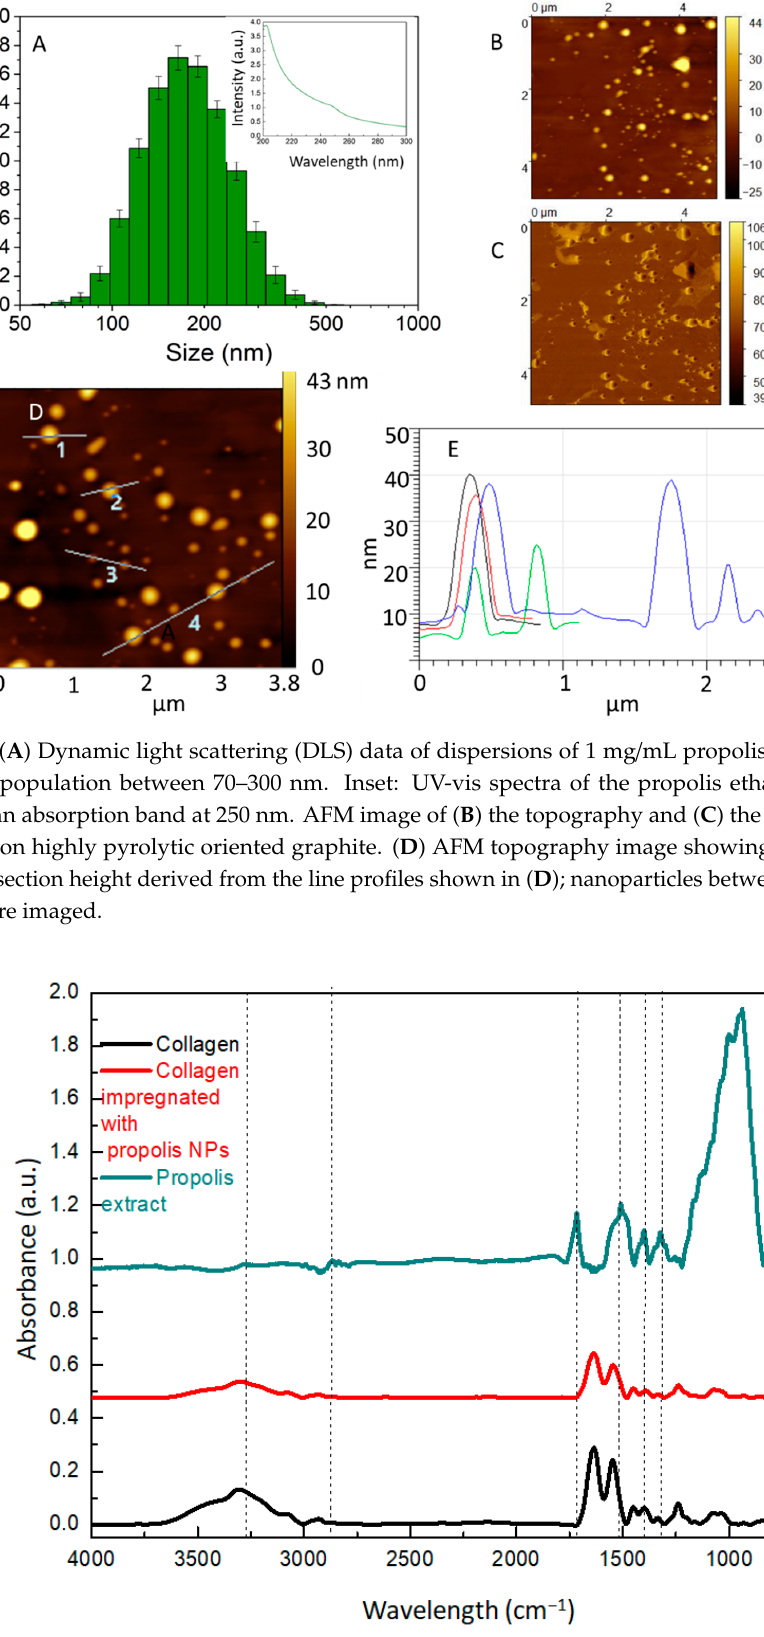
Figure 3. FTIR spectra of the collagen, ethanolic extract, and collagen scaffolds impregnated with propolis NPs.